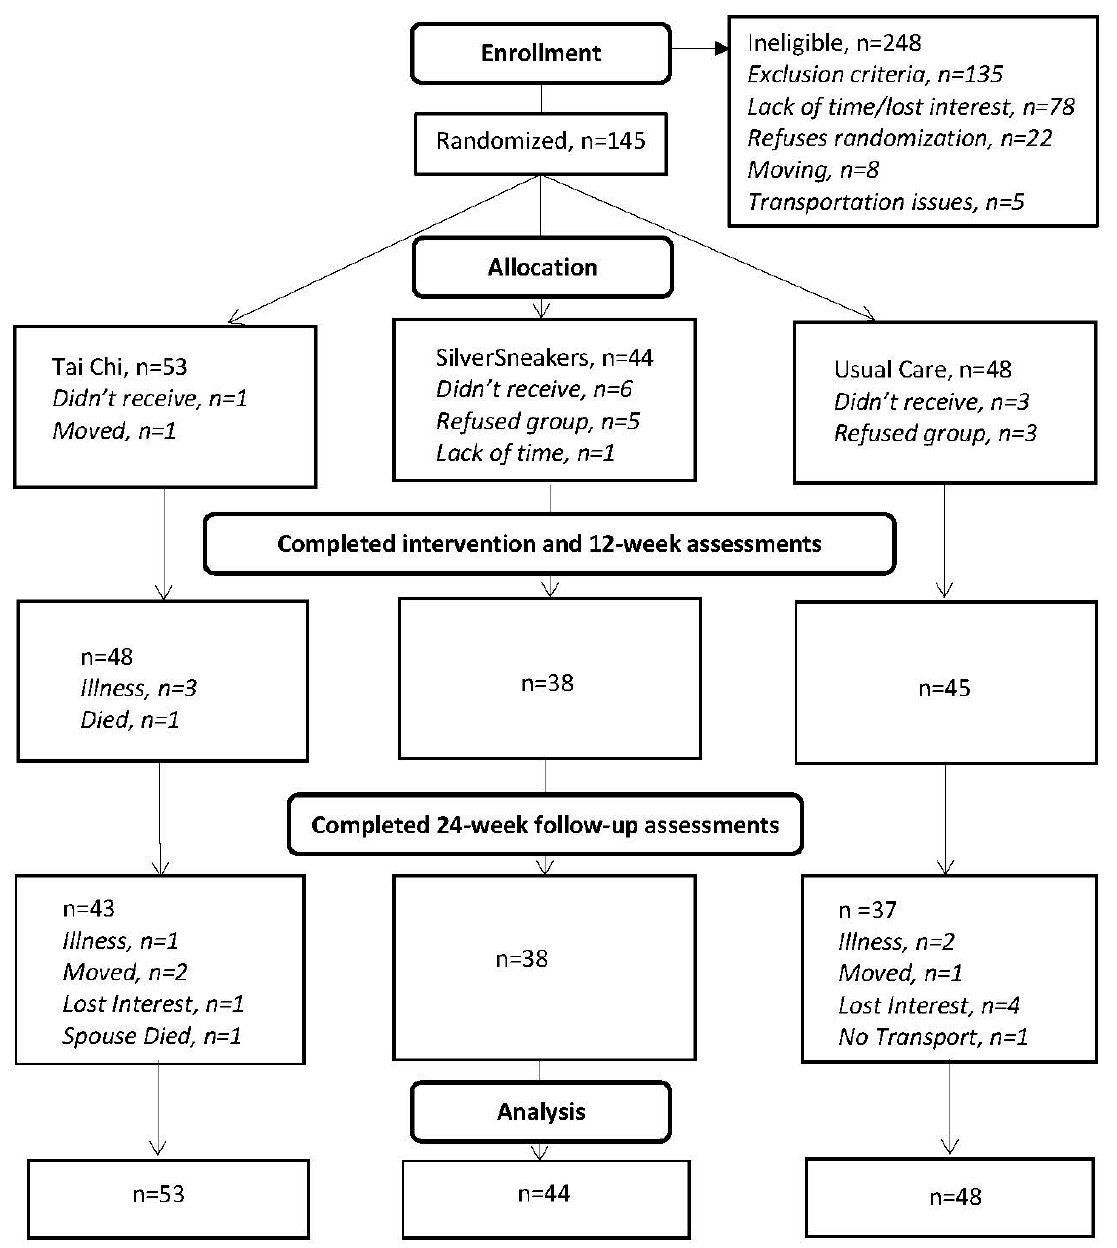
Figure 1. Original Study Flowchart.